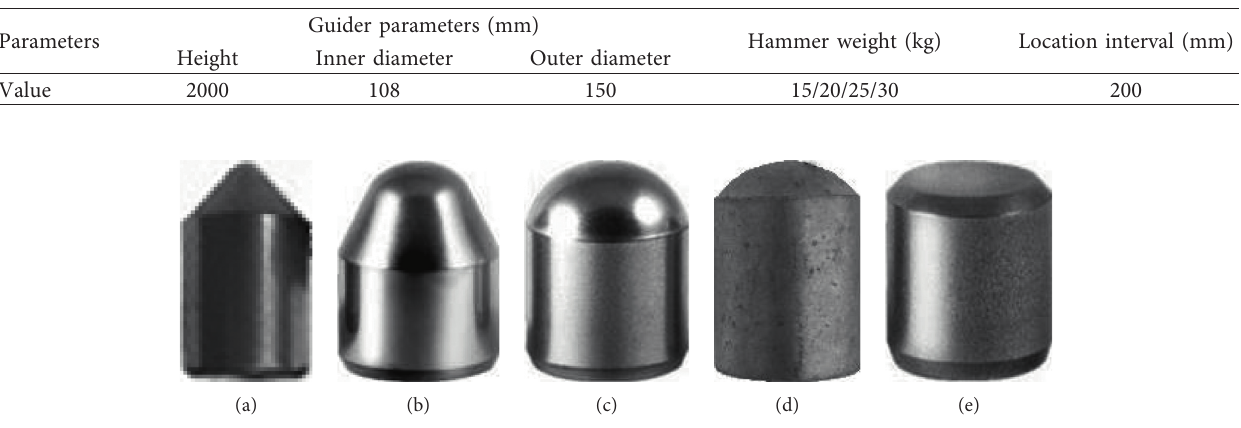
Figure 2: Shape of different indenters: (a) cusp-conical, (b) warhead, (c) hemispherical, (d) spherical-arc, and (e) flat-top.